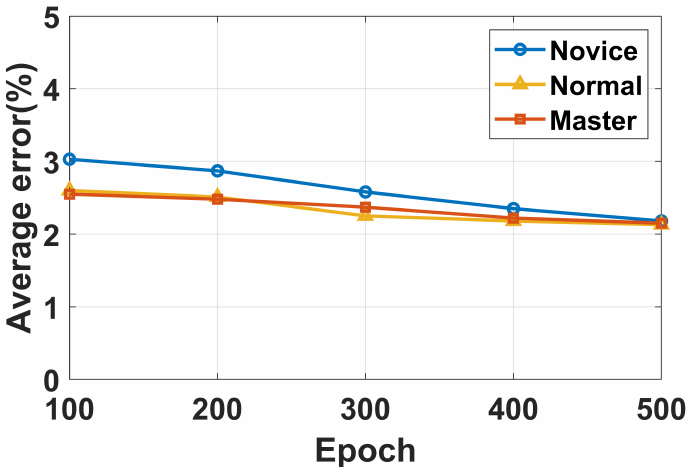
Figure 14. Average evaluation error with varied